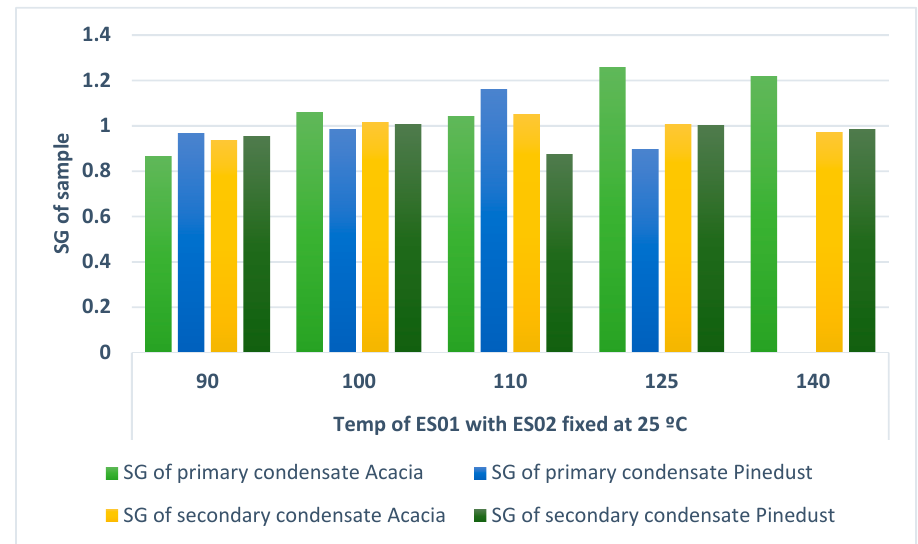
Figure 5. Specific gravity (SG) of various bio-oil fractions at di ff erent primary condenser temperatures .